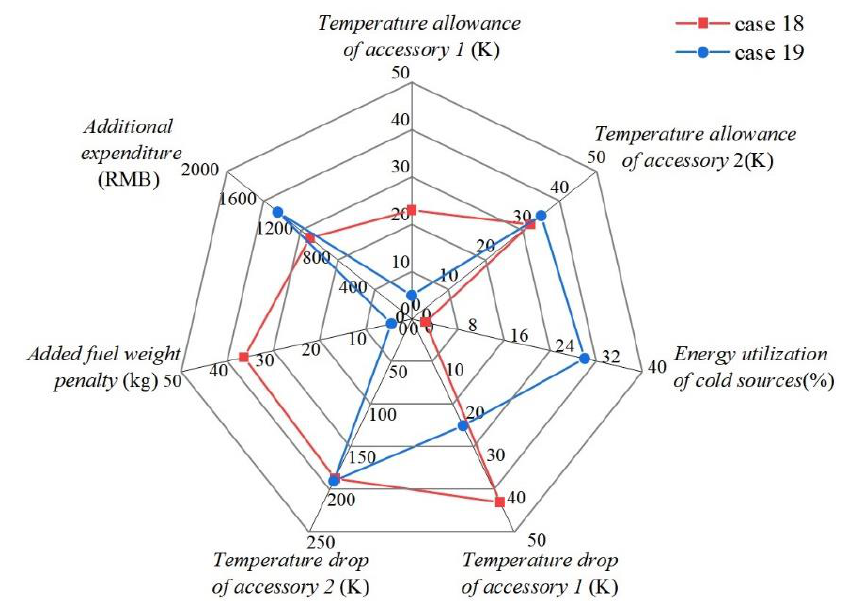
Figure 27. The comprehensive assessment of case 18 and case 19.